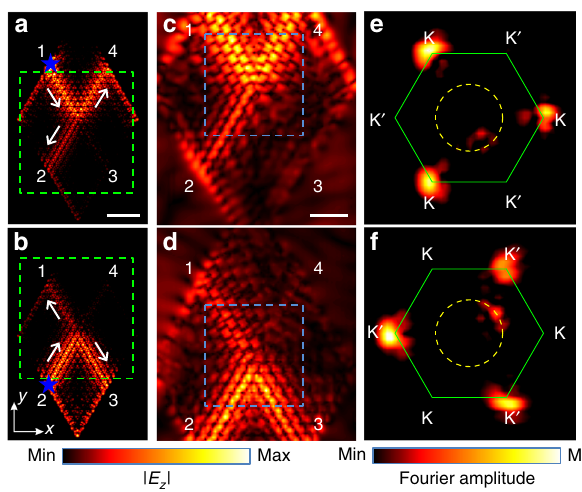
Fig. 5 Near- fi eld maps of valley-polarized edge states and corresponding spatial Fourier spectra. a , b Simulated fi eld maps of E z component at 7.50 GHz on the xy plane 1 mm above the metallic surface. The source denoted by the blue star is placed at terminal 1 in a and terminal 2 in b . Gray arrows denote the direction of the valley-polarized edge states. Green dashed rectangles denote the regions of the area 205× 220 mm 2 scanned in experiments. The scale bar is 60 mm. c , d Measured fi eld maps of E z component at 7.50 GHz in the region of the sample denoted by green dashed rectangles in a and b , respectively. The blue dashed rectangles denote the interior regions where we perform Fourier transforms. The scale bar is 40 mm. e , f Spatial Fourier spectra of the scanned E z component. The green solid hexagons represent the FBZs and the yellow dashed circles represent the 7.50-GHz isofrequency contours of the light cone. The color indicates the amplitude of E z component in fi eld maps and the amplitude of spatial Fourier transforms in spatial Fourier spectra,